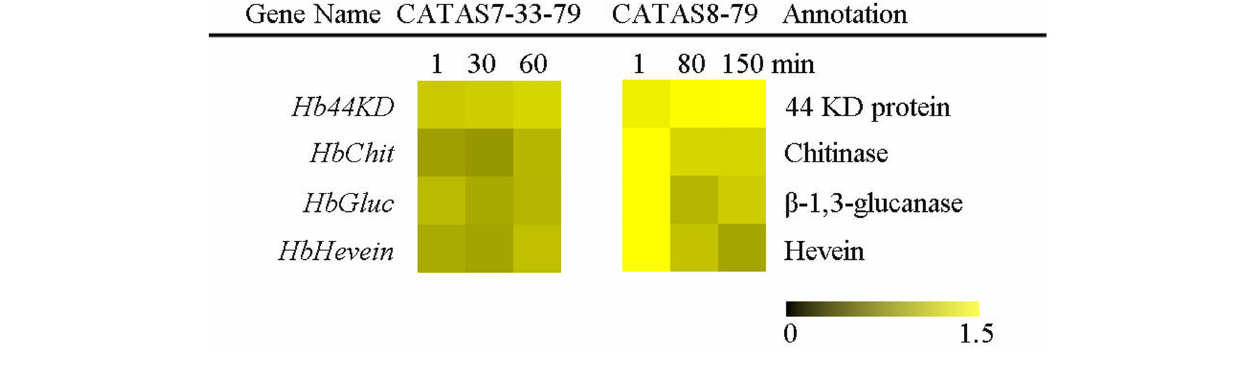
was up-regulated, while all three genes, including HbChit , HbGluc and HbHevein , were down-regulated during latex flow in the latex of